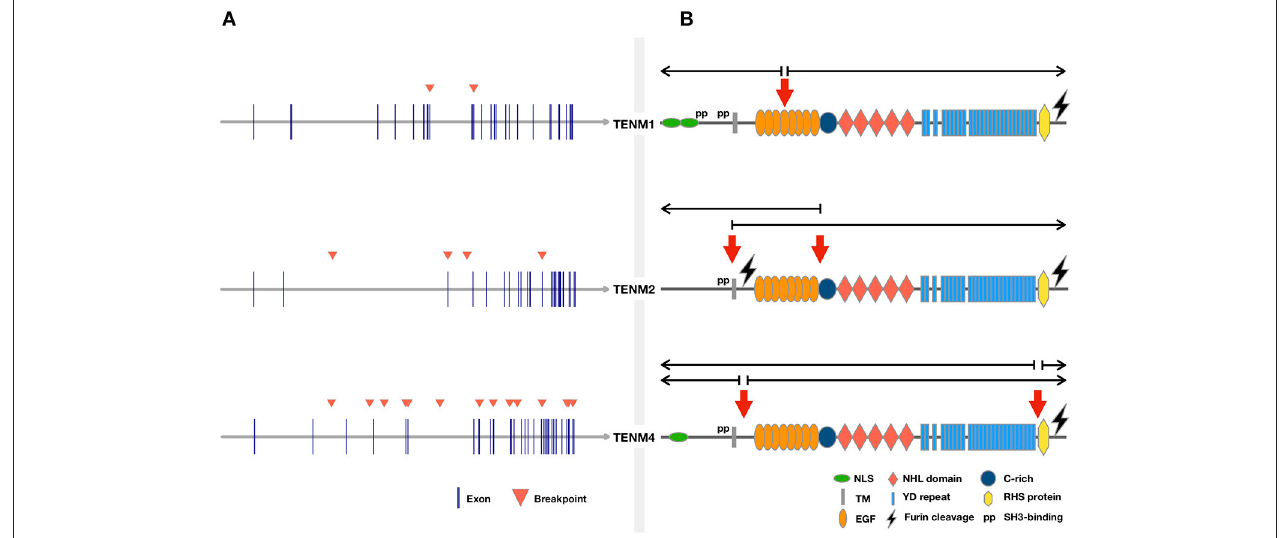
FIGURE 1 | Cancer related translocations involving Teneurin genes . Chromosomal rearrangements were retrieved from the “Atlas of Genetics and Cytogenetics in Oncology and Hematology” and ChimerDB 3.0 by gene searches for each Teneurin. Rearrangements without information on tumor origin were not included. (A) Genomic location of breakpoints from Table 1 are indicated by arrowheads. (B) Predicted location of breakpoints at protein level. Domains are based on structure proposed previously (Tucker et al., 2012). The approximate breakpoint location was estimated from the exon-to-domain correspondence shown in the ENSEMBL v.93 browser. Half open arrows over the breakpoint indicate the predicted portion of the protein retained in the resulting translocation product.